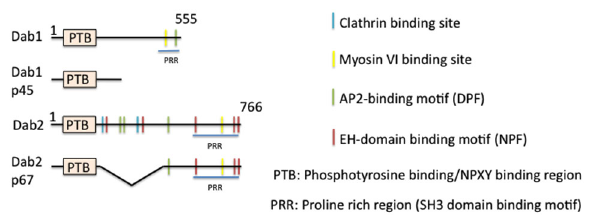
FIGURE 4 | Domain structure of mammalian disabled (Dab) and its isoforms . The domain structure of disabled and of its isoforms is depicted. Binding regions are indicated by color